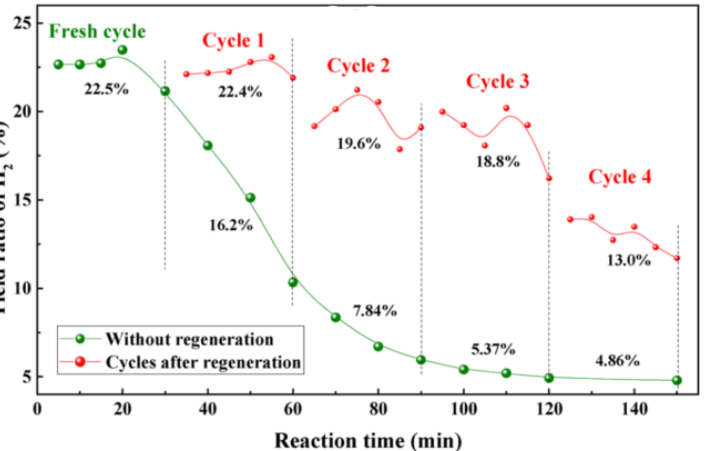
Figure 16. H 2 yield of a metal-impregnated cracking Ni/ γ -Al 2 O 3 catalyst after different cycles of regeneration with oxygen for 3 h. Lu et al. [128]. Table 3. Standard potential of oxygen, ozone, and principal oxygenated radicals at 25 ◦ C and 1